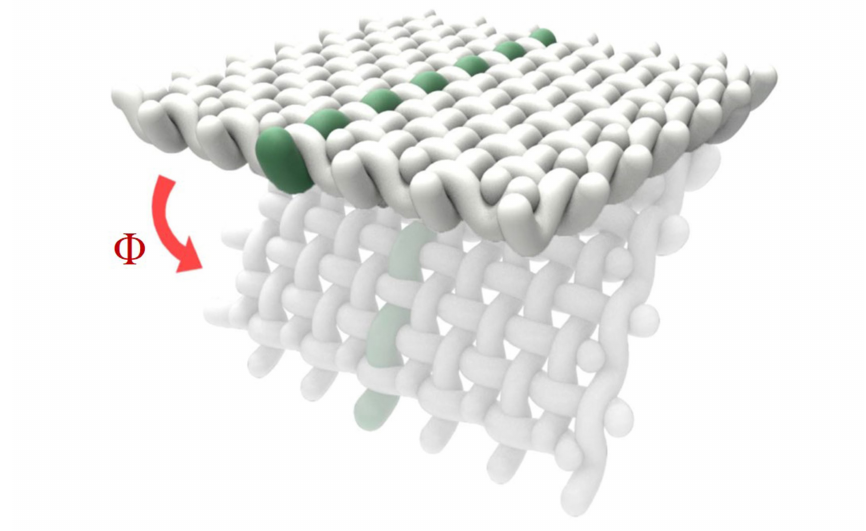
Figure 1. Schematic of the textile-based piezoelectric sensor (green) in the smart textile under flexural